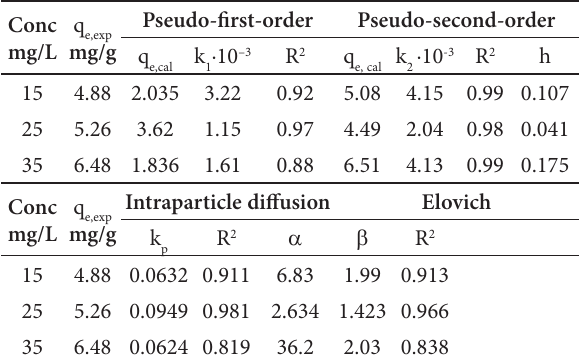
Table 2. Kinetic parameters for the sorption of Cu 2+ onto the